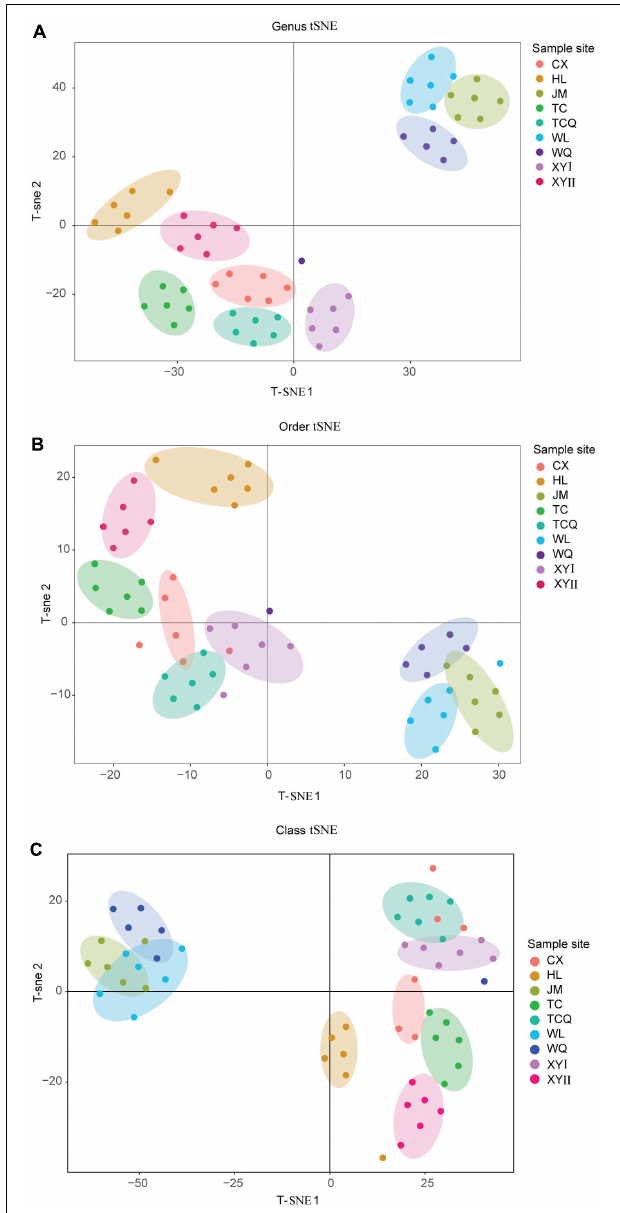
FIGURE 6 | TSNE analysis of CPB collected from different areas. Each point represents a sample, and each color represents a sample site. (A) TSNE analysis at the genus level. (B) TSNE analysis at the order level. (C) TSNE analysis at the class level.